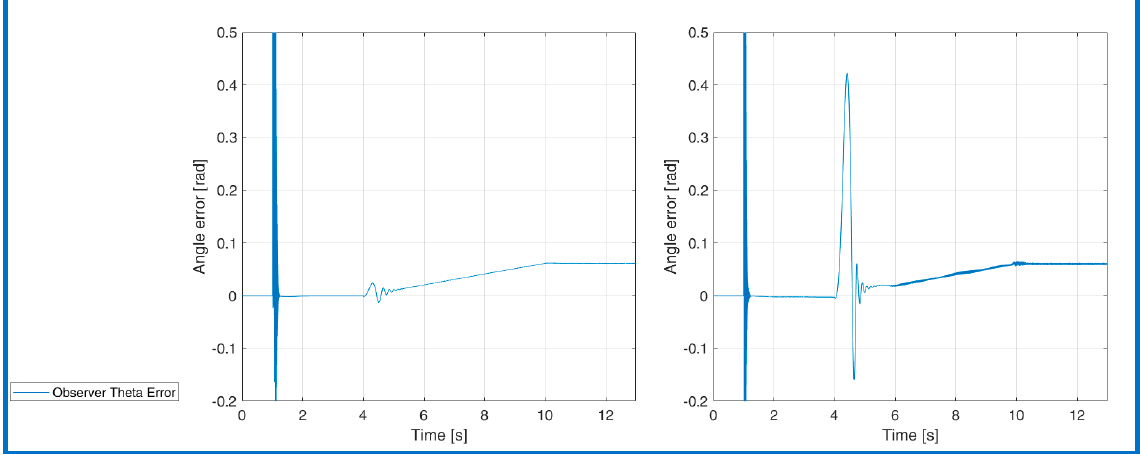
Figure 13. Observer rotor flux angle error with ideal generators (left) and with inverter (right).